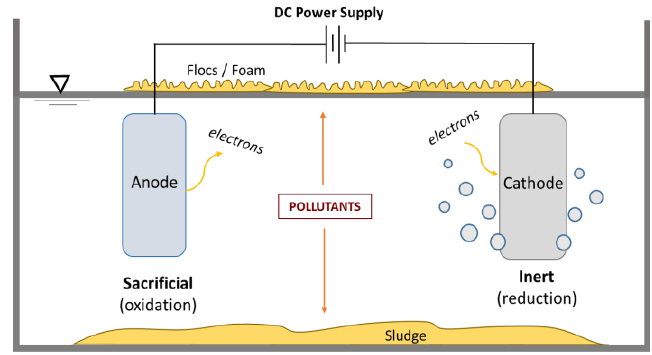
Figure 1. General schematic representation of electrocoagulation (EC).